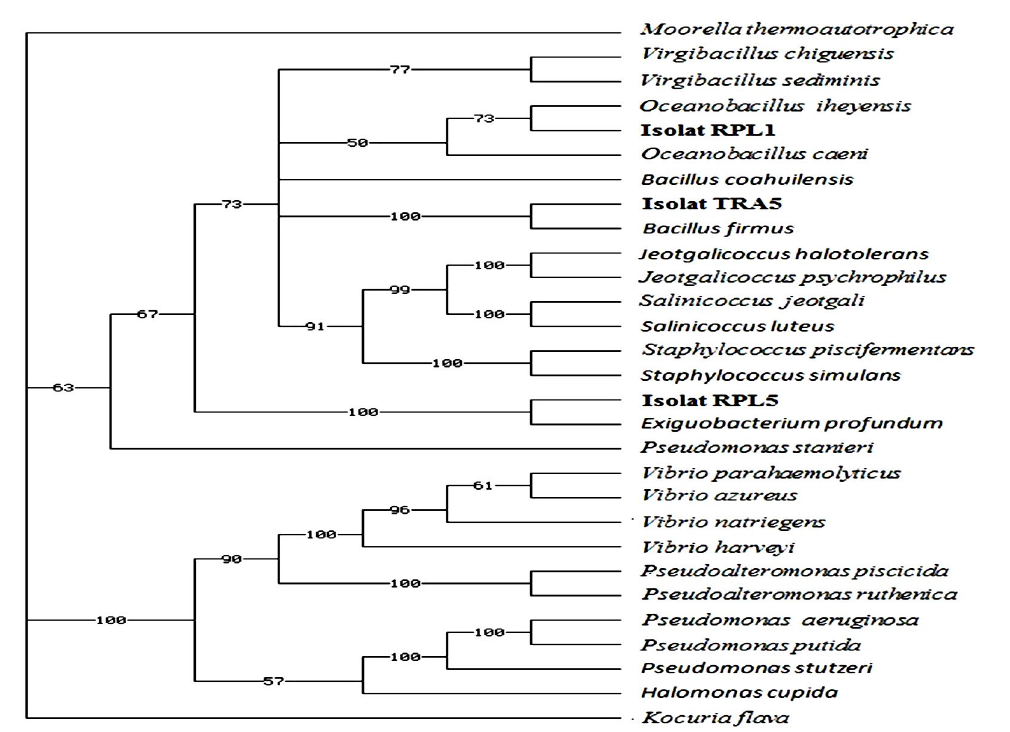
Fig. 4. Phylogenetic tree reconstruction results